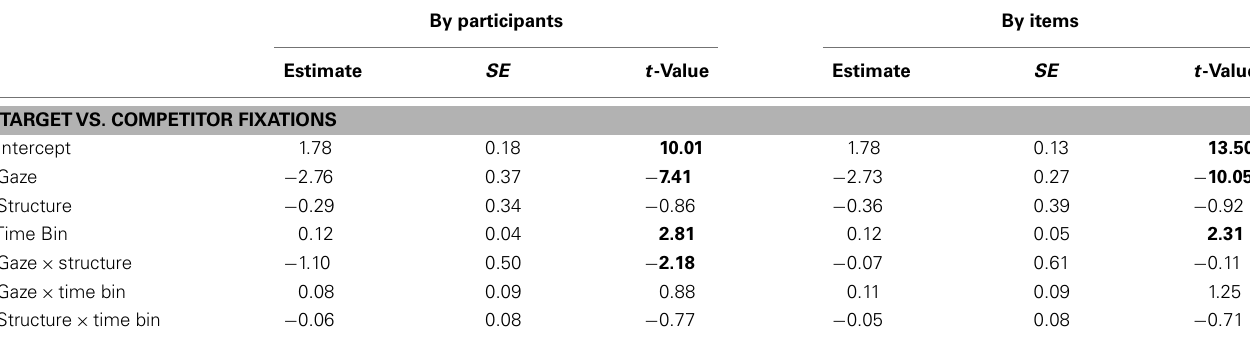
Table 7 | Experiment 2, NP2 time window: coefficients, SE and t -values for the final models of log-ratios of target fixations. By participants By items Estimate